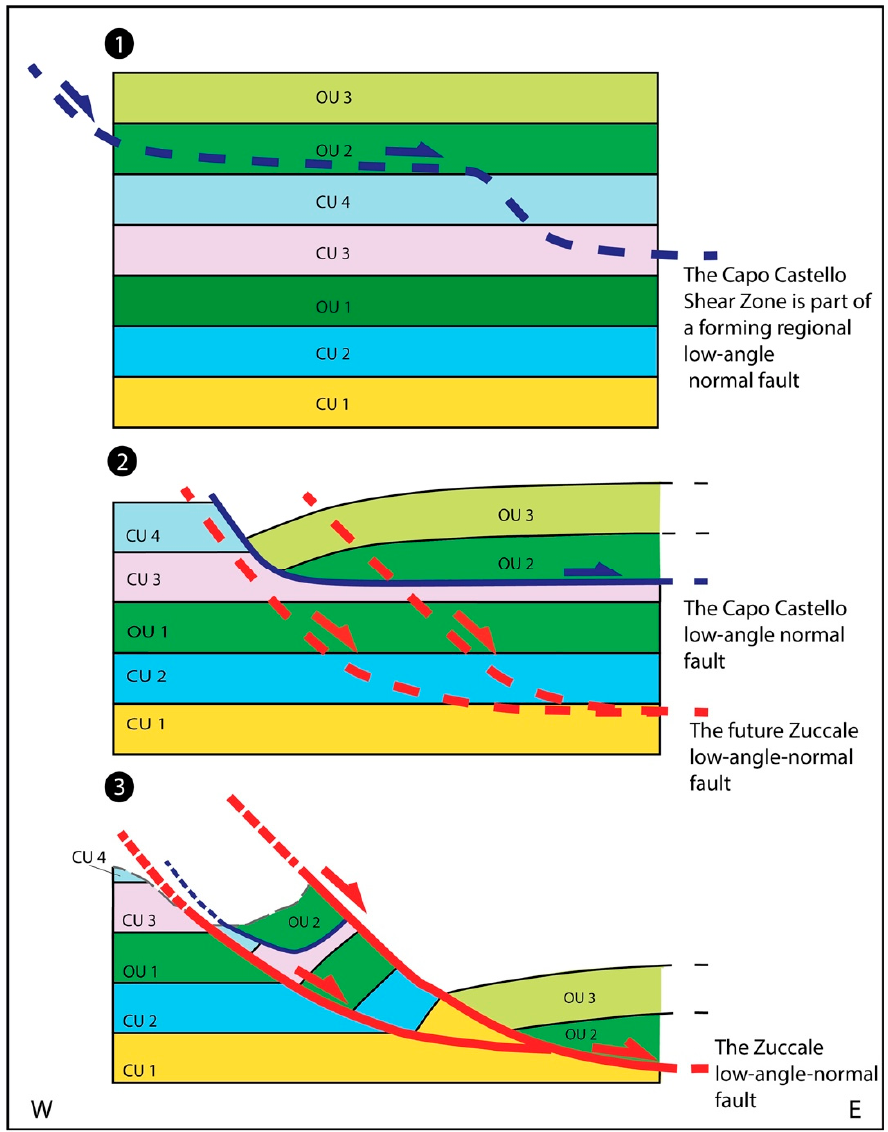
Figure 15. Tectonic scheme, not to scale, showing the tectonic omission, caused by the low angle normal fault to which the Capo Castello shear zone belongs, and its relationship with the low-angle Zuccale normal fault, in the stacked pile. From the top to the bottom: ( 1 ) the original Elba Island stacked pile linked to the Late Oligocene–early Miocene collisional phase; ( 2 ) the tectonic omission linked to the activity of the low angle normal fault to which the Capo Castello shear zone is associated; the Oceanic Unit 2 is in direct contact with the continental unit 3; ( 3 ) the tectonic omission generated by the Zuccale normal fault along which the Oceanic unit 3, the highest unit in the tectonic pile, overlay the deepest continental unit 1. Symbols indicate the Oceanic (OU) and the Continental Units (CU) stacked during the orogenesis. See also Figure 1.